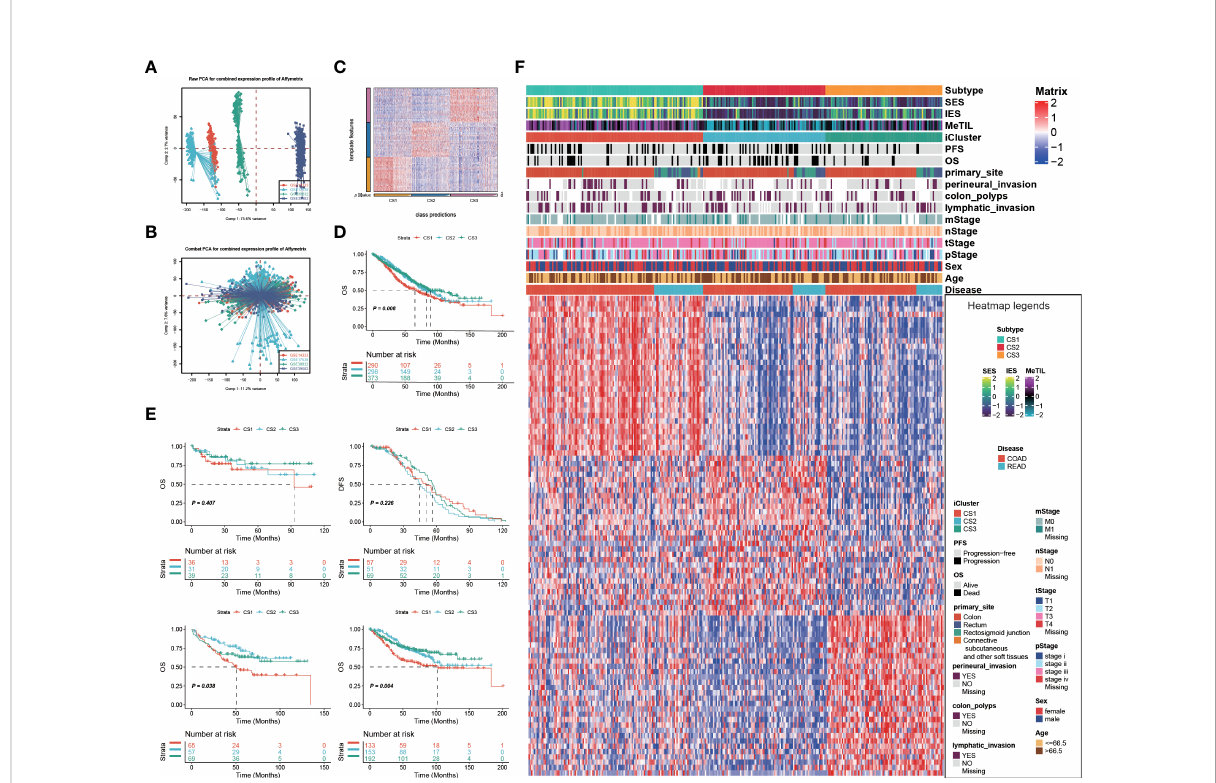
FIGURE 3 Identi fi cation of transcriptome biomarkers for colorectal cancer subtype. Principal component analysis to investigate the potential batch effect among four GEO datasets (A) before and (B) after Combat. (C) Heatmap showing the transcriptome expression pattern of the 120-gene signature in nearest template predicted cancer subtype of GEO cohort. (D) Kaplan-Meier curves of OS with log-rank test for 961 patients with colorectal cancer according to the eligible predicted classi fi cation. (E) KM of os using ntp in GEO (F) Heatmap showing the transcriptome expression pattern of the 90-gene signature (30 uniquely signi fi cantly upregulated genes in each cancer subtype) in TCGA